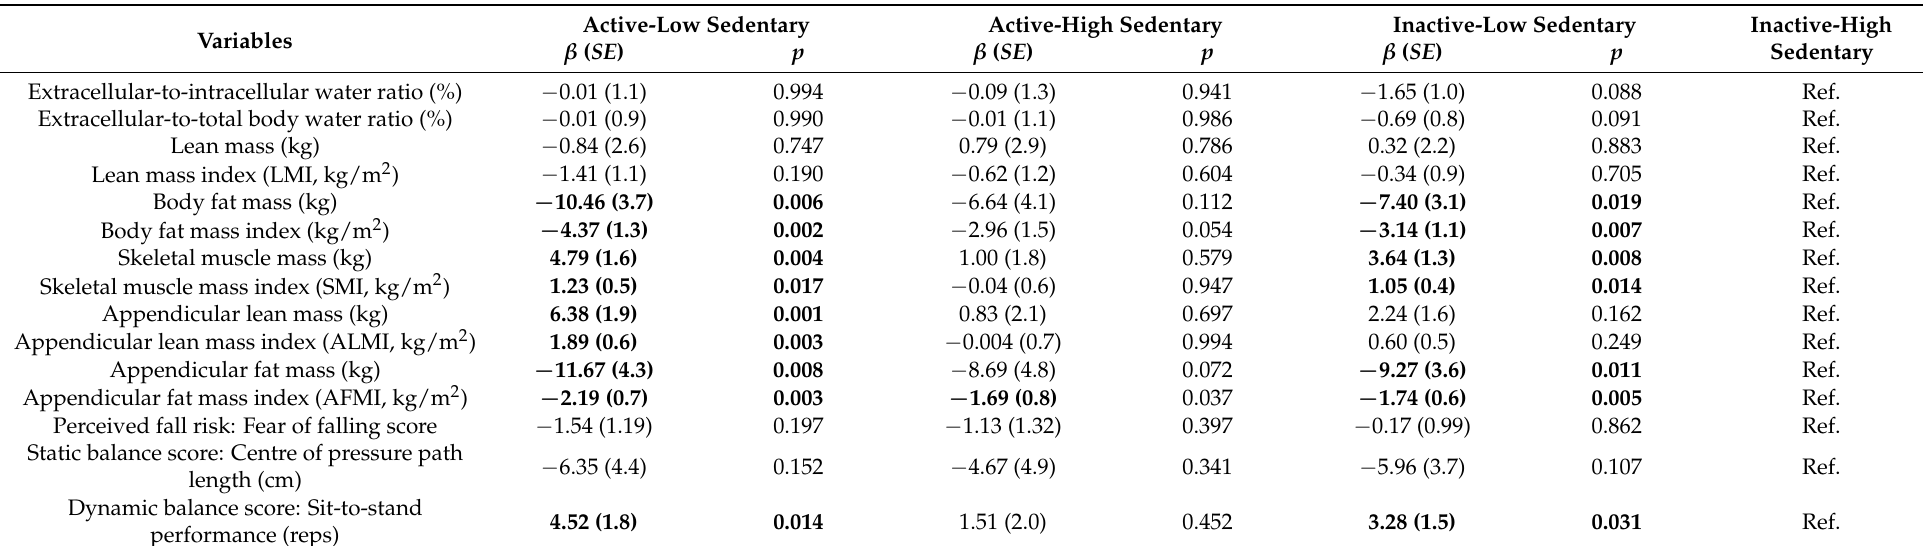
Table 3. Associations with body composition and balance tests—results from the multiple linear regression